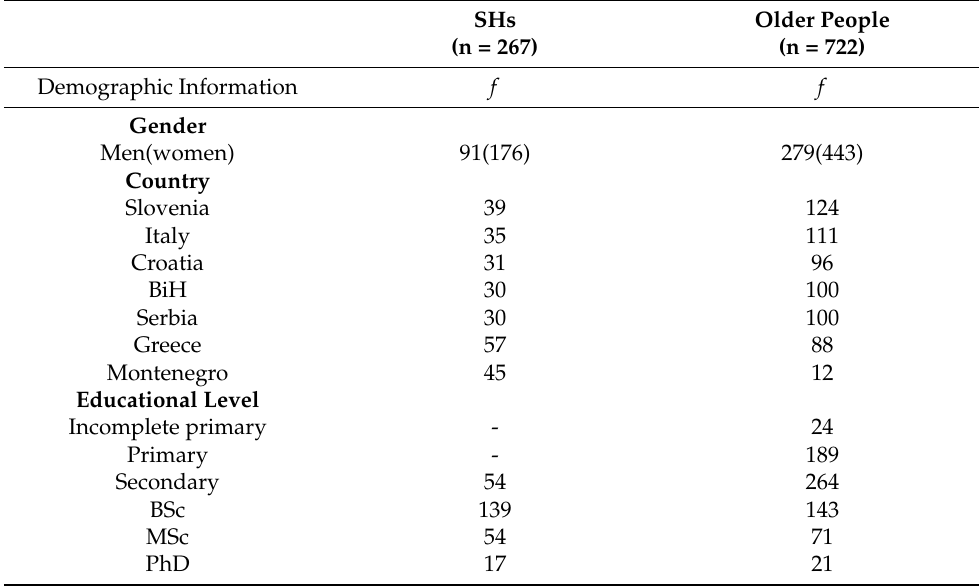
Table 1. Demographic characteristics of SHs and older participants.